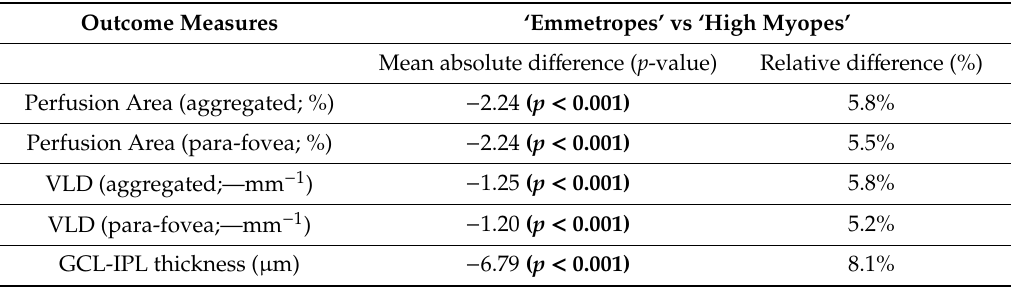
Table 2. Multiple comparisons (post-hoc) of vascular density between short versus long eyes.